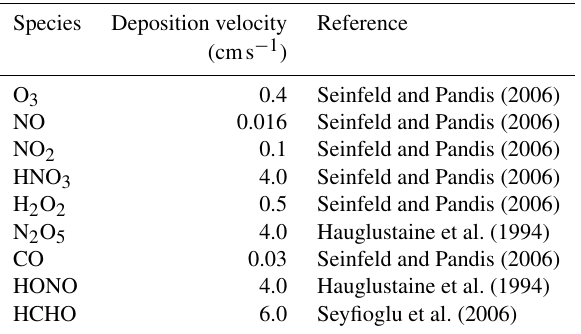
Table 2. Dry deposition velocities used in model simulations for different atmospheric